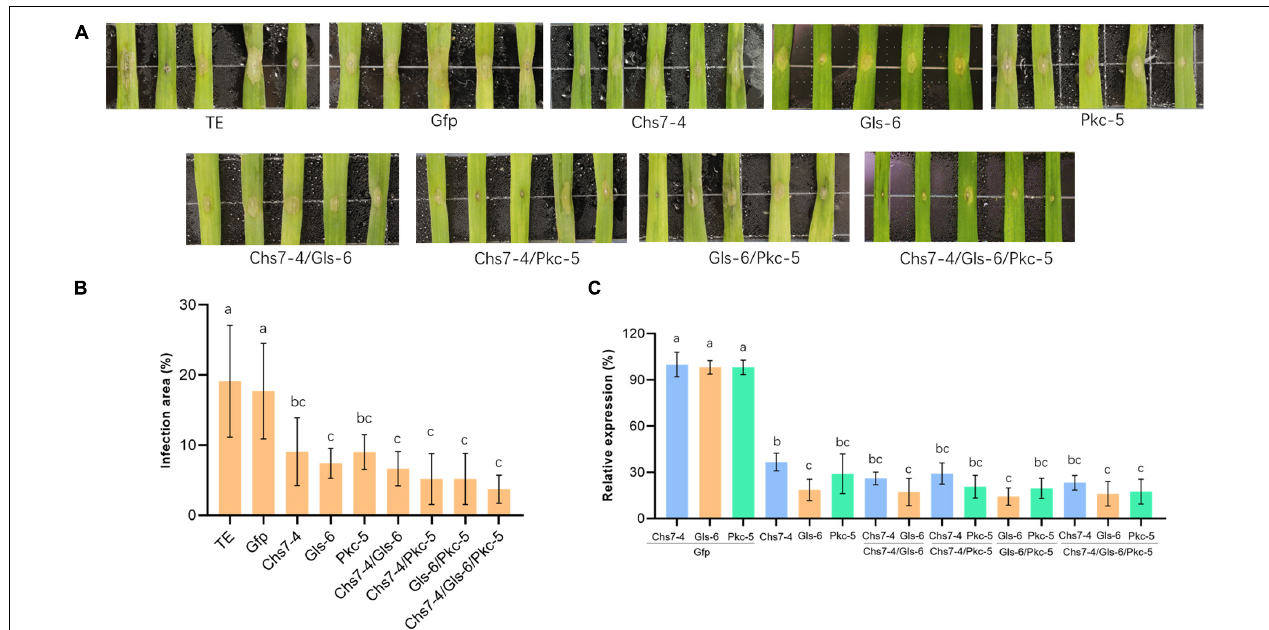
FIGURE 4 | Infection of Fusarium graminearum (Fg) on wheat leaves sprayed with different dsRNAs. (A) Phenotypes of representative wheat leaves sprayed with dsRNAs and inoculated with Fg at 3 dai. (B) Infection area, illustrated as percentage of the total area from 20 leaves for each dsRNA and TE control at 3 dai. Error bars indicate standard errors (SE) of two independent experiments. Different letters indicate statistical significance ( p < 0.01; ANOVA). (C) Expression of Chs7 , Gls , and Pkc genes. Relative gene expression was assayed by qRT-PCR and normalized to fungal β - tubulin as a reference gene. Total RNA was extracted from detached wheat leaves sprayed with different dsRNAs and inoculated with Fg at 3 dai and reversely transcribed into cDNA. Error bars indicate SE of two independent experiments. Different letters indicate statistical significance ( p < 0.01;